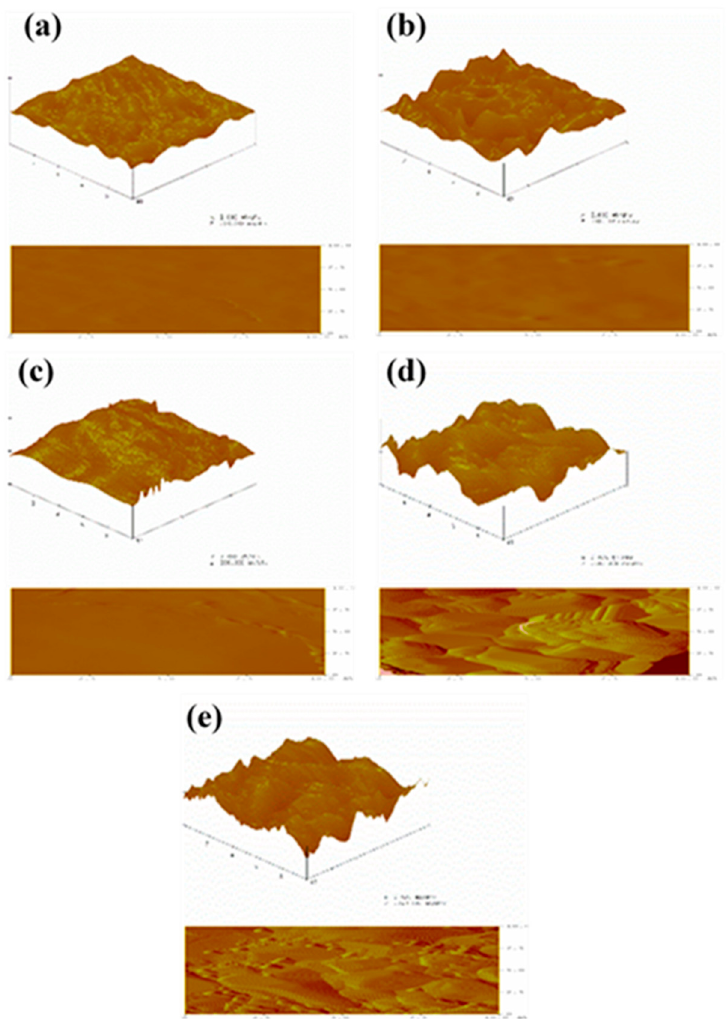
Table 4. Roughness of the obtained composite films.